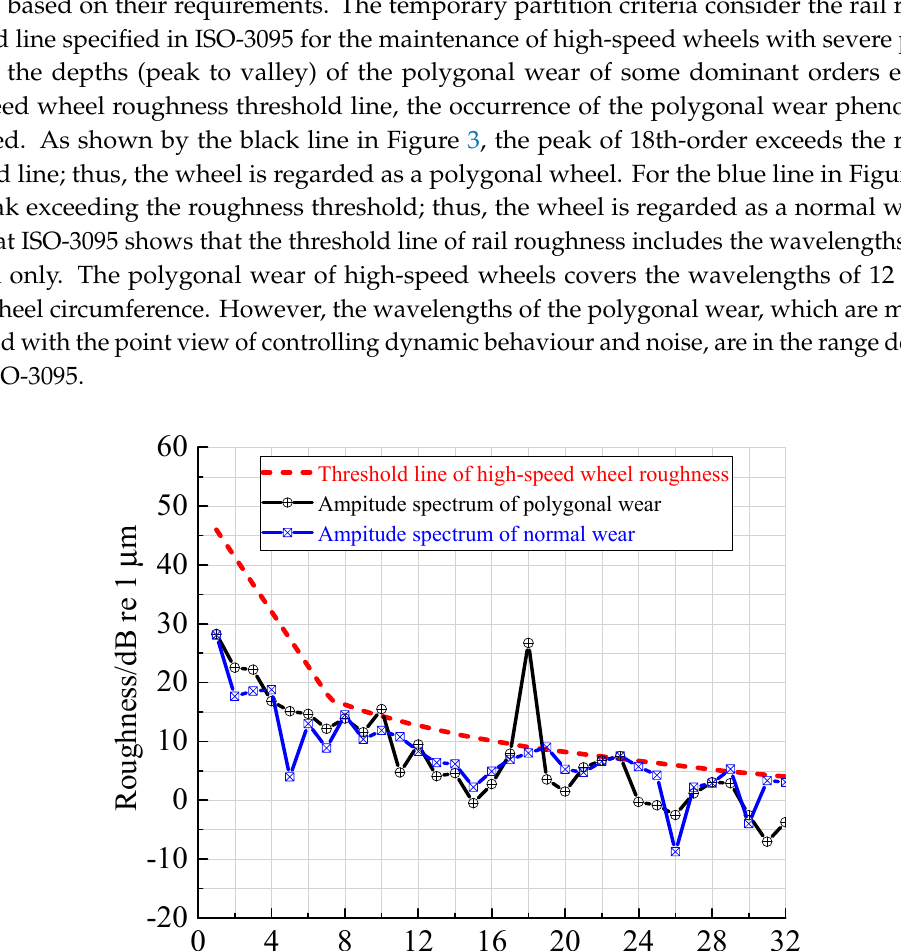
Figure 3. Sketch map: Amplitude spectrum of polygonal wear (site measurement) and threshold line of high-speed wheel roughness (referring to the ISO-3095).